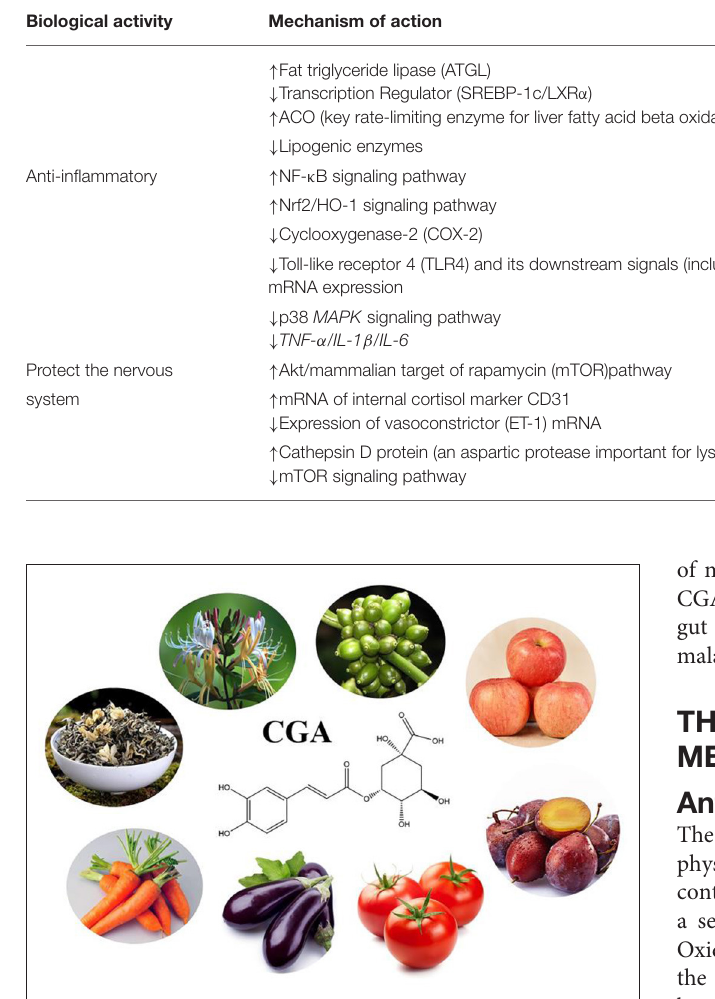
FIGURE 2 | The main source of